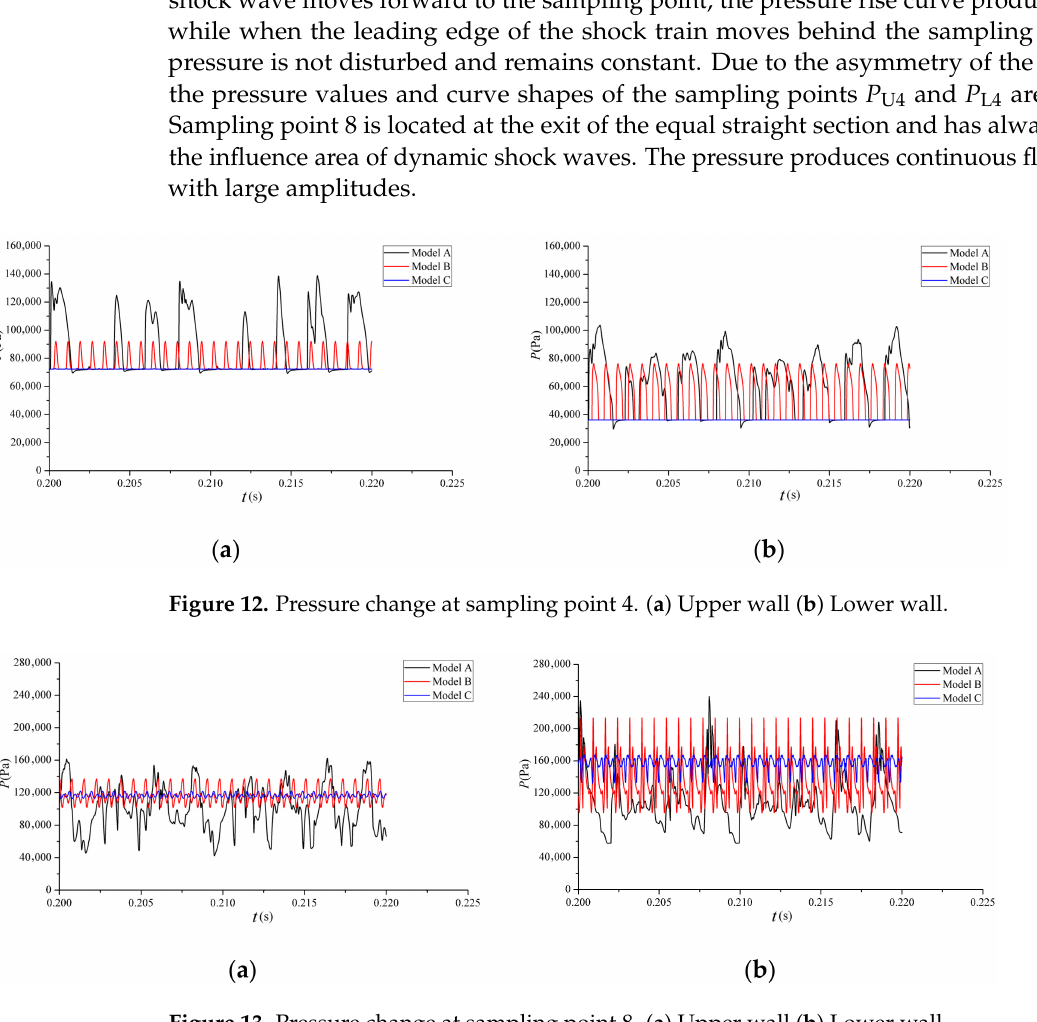
Figure 13. Pressure change at sampling point 8. ( a ) Upper wall ( b ) Lower